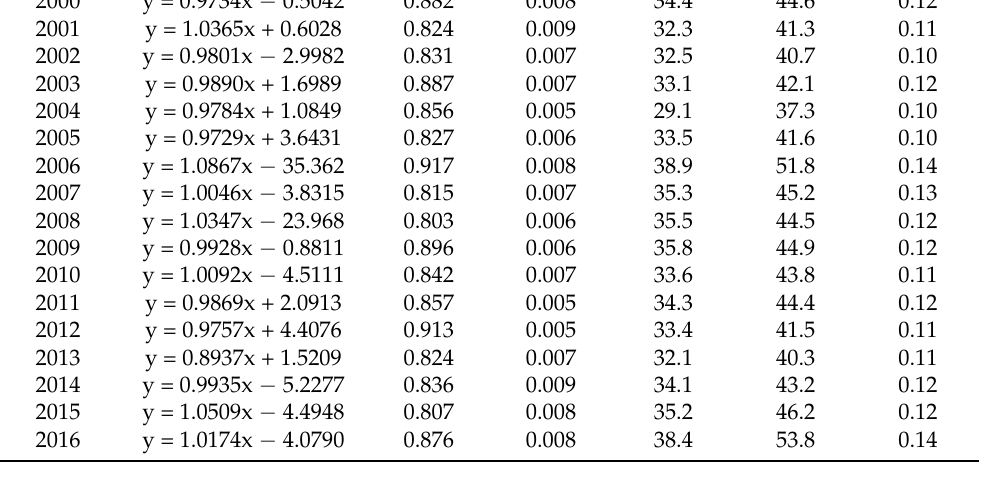
were less than 0.01, meeting the statistical requirements (Figure 4). The mean absolute error ranged from 29.1 to 38.9, the root mean square error ranged from 37.3 to 51.8, and the mean relative error ranged from 0.10 to 0.14, all within a reasonable range. The slope of the fitted equation between MODIS NPP products and predicted values ranged from 0.8937 to 1.0867, close to 1. The prediction results were evenly distributed and did not show any overall bias, indicating that the model has good applicability. Table 4. The error of simulated values with MOD17A3 NPP product. Time